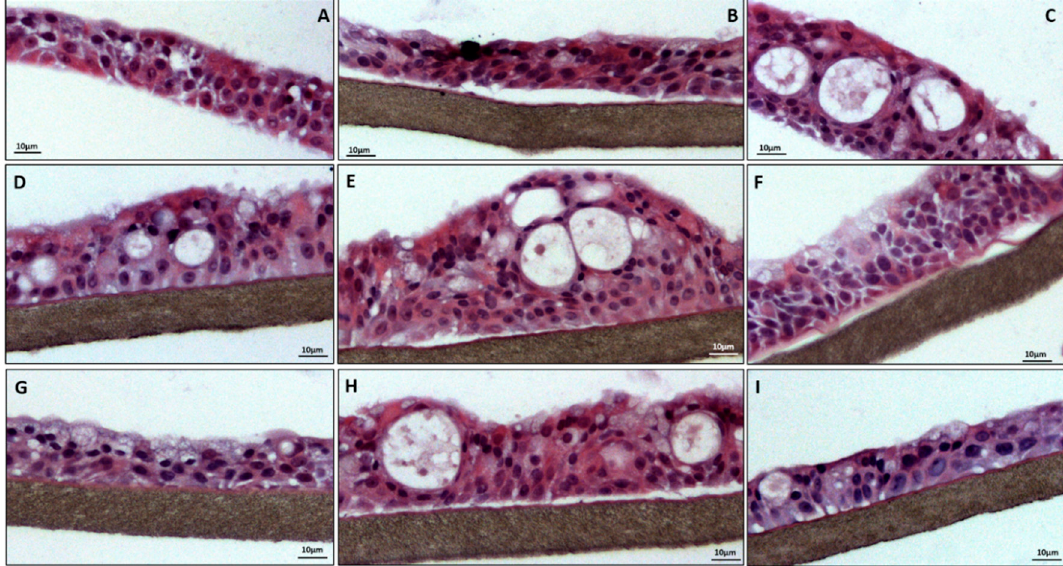
Figure 6. Bright-field images of human bronchial epithelial cells stained with haematoxylin and eosin. All images were taken following a 24 h exposure to CFA and CFA leachates. ( A ) H 2 O control, ( B , C ) PM 2.5 CFA exposure, ( D ) PM 10 CFA exposure, ( E ) 1 h H 2 O CFA leachate exposure, ( F ) 48 h H 2 O CFA leachate